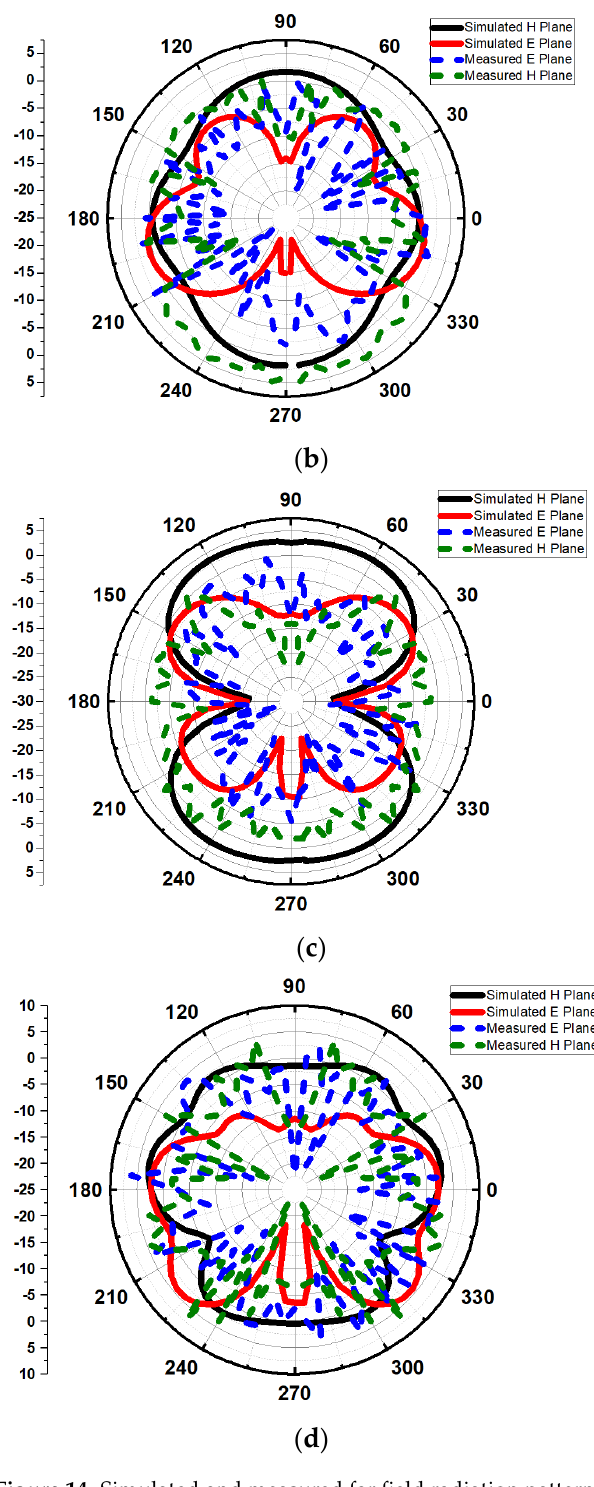
Figure 14. Simulated and measured far field radiation patterns of presented antenna at ( ∅ = 90°) and ( ∅ = 0°) for ( a ) 2.53 GHz, ( b ) 8.43 GHz, ( c ) 11.88 GHz, and ( d ) 18.51 GHz.